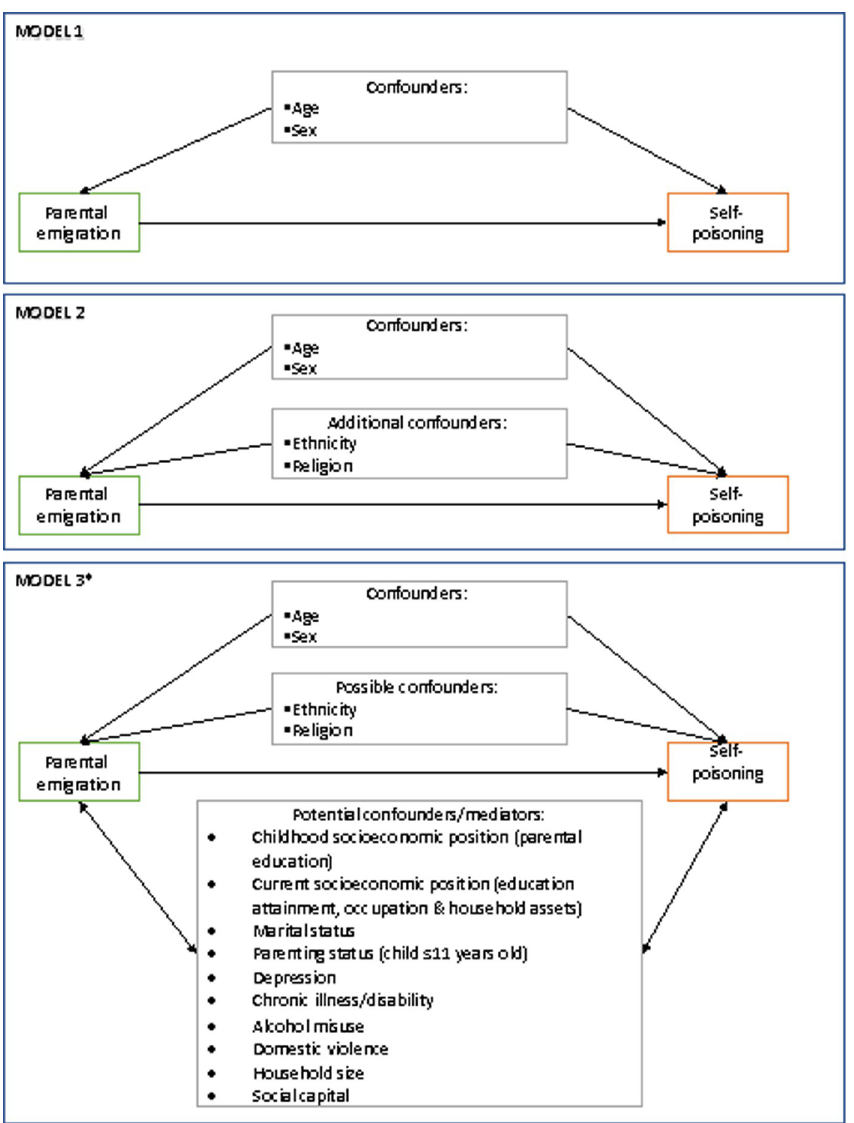
Fig 1. Graphical presentation of the conceptual models used to inform statistical analysis.